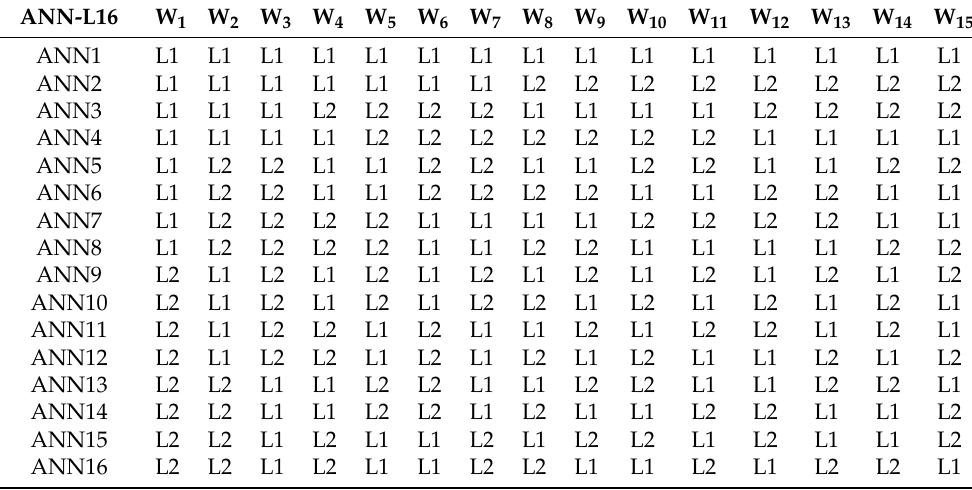
Table 3. ANN-L16 orthogonal vector